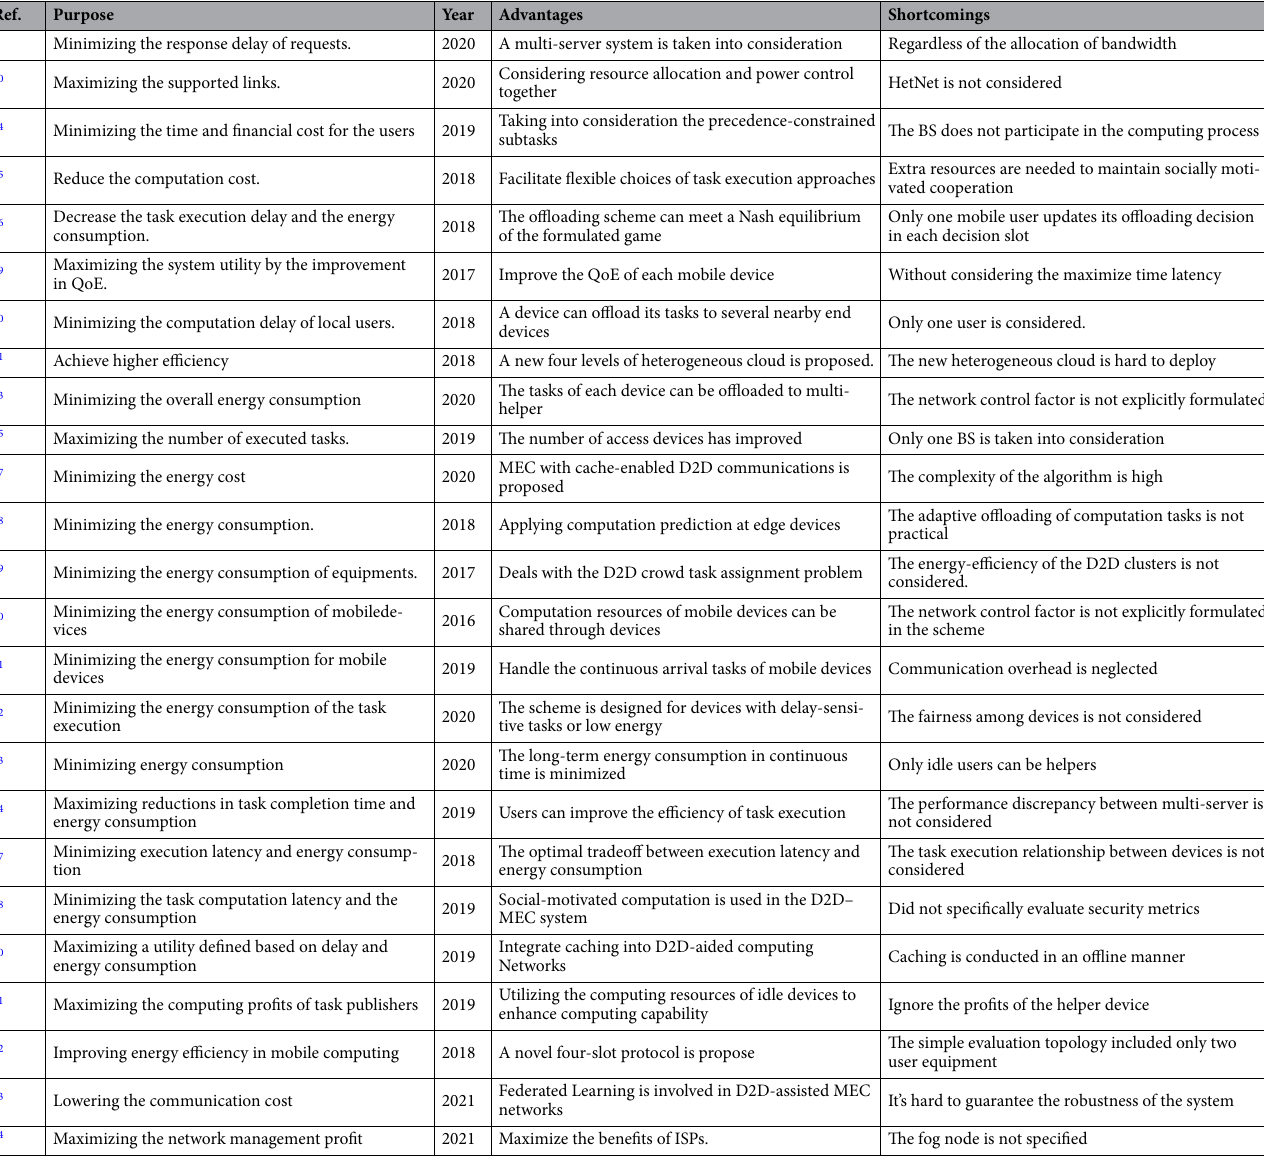
Table 1. The comparison of the related